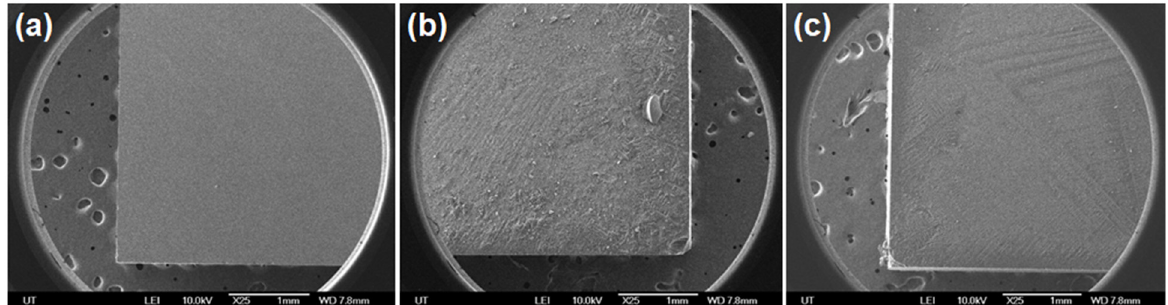
Figure 5. Scanning electron microscopic images of biofilm on glass slide before and after phage treatment. Where ( a ) Cover slip, ( b ) Bacterial biofilm, ( c ) Surface with phage treatment, all are under 1mm at 10 kV.